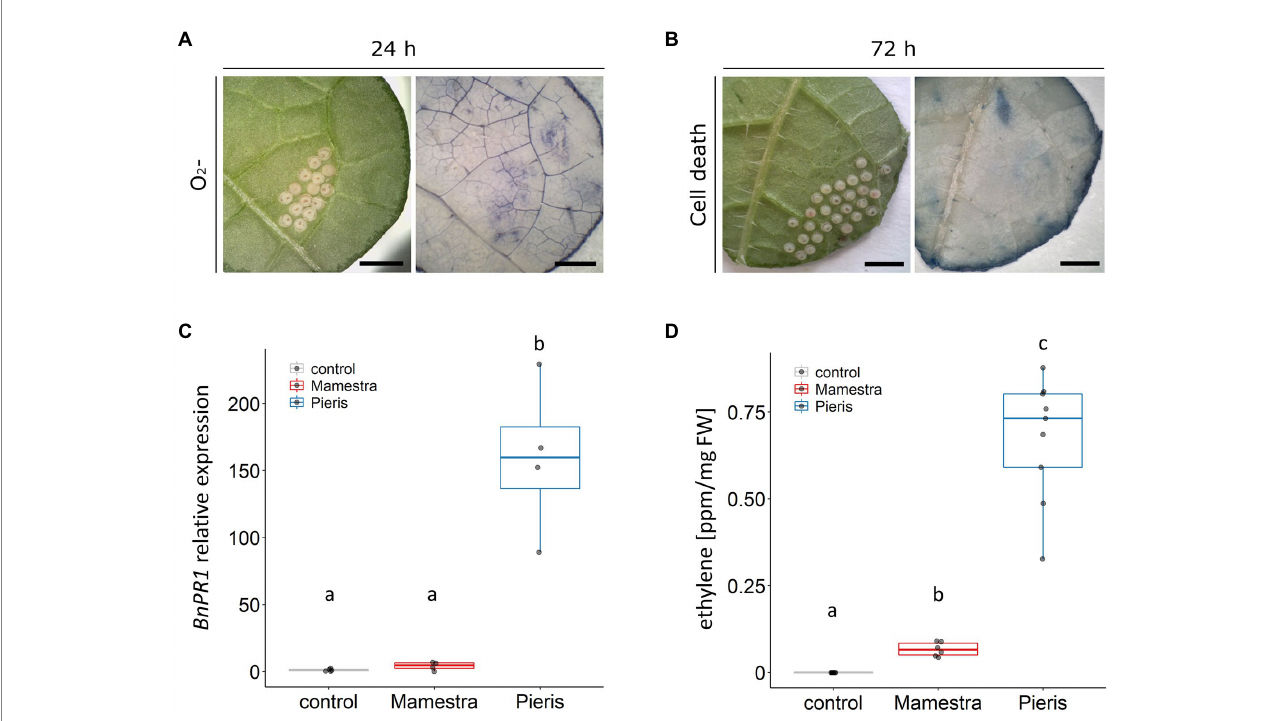
FIGURE 4 Responses to eggs and egg wash of M. brassicae in B. nigra . (A) Leaf of B. nigra oviposited on by M. brassicae moth by NBT showing light O2 • − accumulation underneath M. brassicae eggs. (B) Leaf stained by trypan blue showing no cell death underneath M. brassica e eggs. (C) BnPR1 expression in leaf tissue treated with control solution, P. brassicae wash or M. brassicae wash. Different letters indicate significant differences in mean PR1 expression (ANOVA followed by Tukey, p < 0.01). (D) Ethylene production in B. nigra leaf in response to egg washes. The height of the boxes in C,D represents the first to the third quartile of the range; the horizontal line within the box is the median; the whiskers indicate the data minimum and maximum; and dots represent data points. Values that have no accompanying letters in common differ significantly in production of ethylene (Kruskal–Wallis followed by pairwise Wilcoxon test, p < 0.001). Scale bars = 1